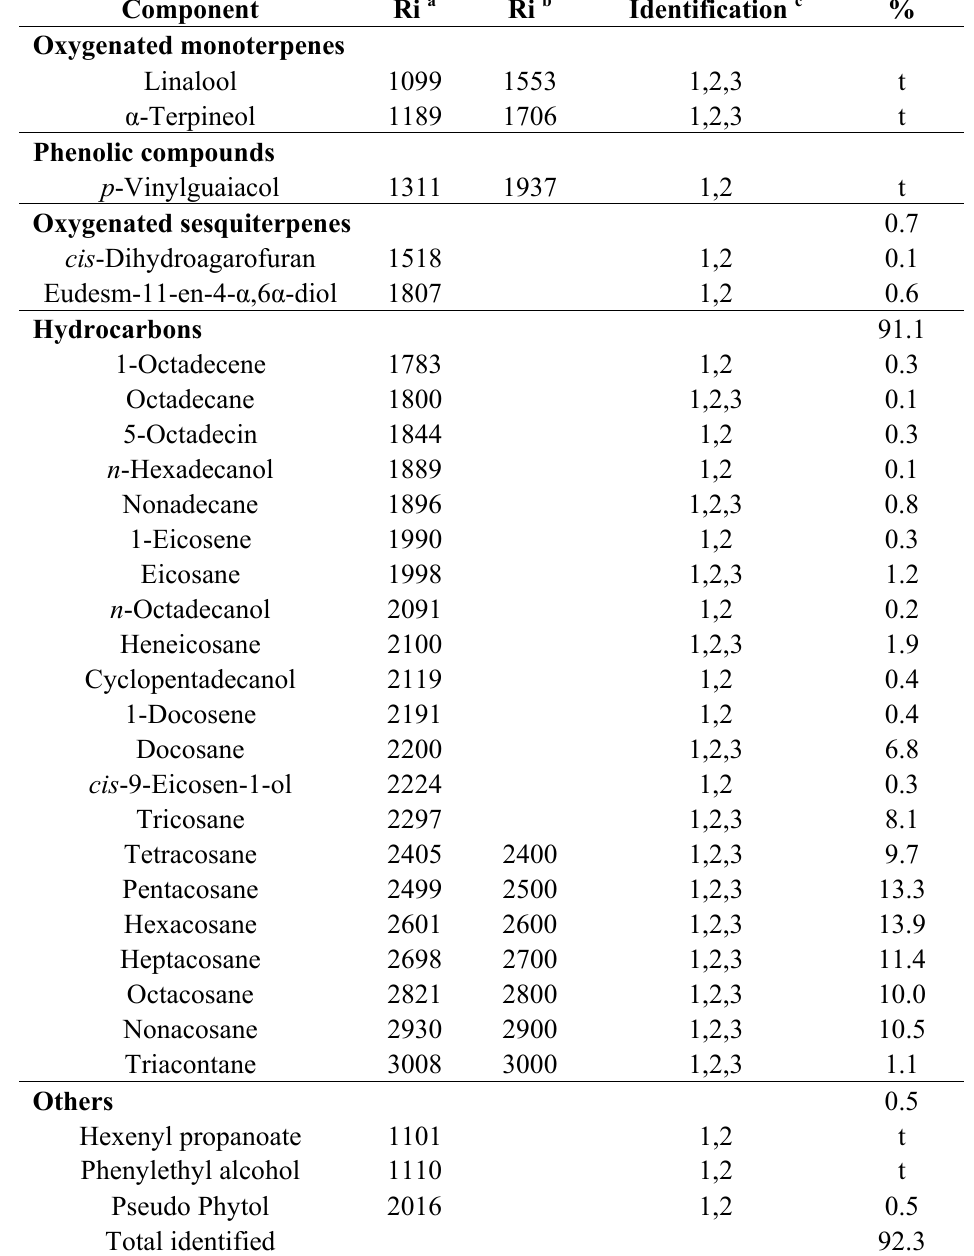
Table 1. Chemical composition of the leaf essential oil from Moringa